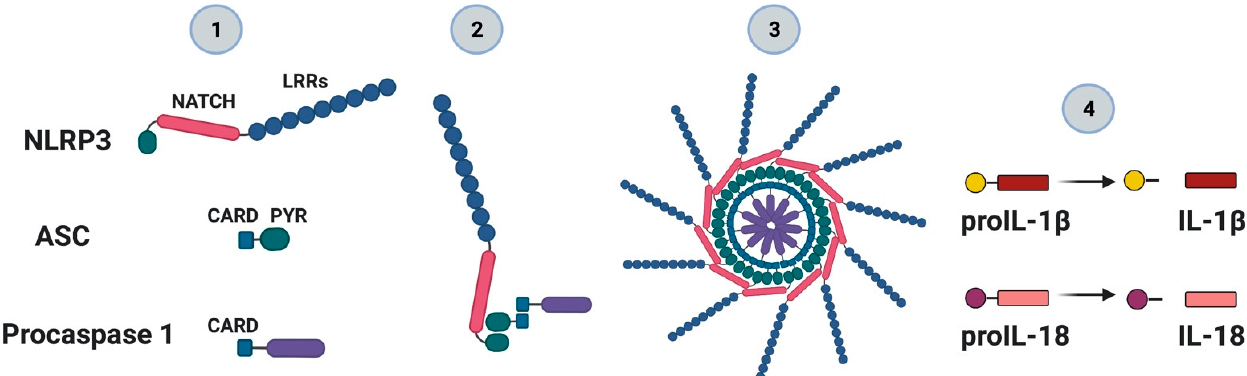
Figure 2. The nucleotide-binding oligomerization domain-like receptor family (NOD-like) pyrin domain containing 3 (NLRP3) inflammasome complex. The NLRP3 inflammasome is part of the NLR protein family which contains a pyridine 3 domain (NLRP3). The NLRP3 protein (1), through the internal interaction between the NACHT domain (or also referred to as NOD) and LRR (leucine-rich repeats), is self-repressed under normal cellular conditions. In the presence of pathogen-associated molecular patterns (PAMP) of microorganisms, damage-associated molecular patterns (DAMP) or metabolic perturbances, this self-repression is removed. The exposition of the NACHT domain leads to the oligomerization and recruitment of both ASC protein—through its PYR domain—and procaspase-1 through its CARD domain (2). Oligomerization or assembly triggers the activation of caspase-1 (3) and the processing of pro-inflammatory interleukins such as IL-1 β and IL-18 (4).